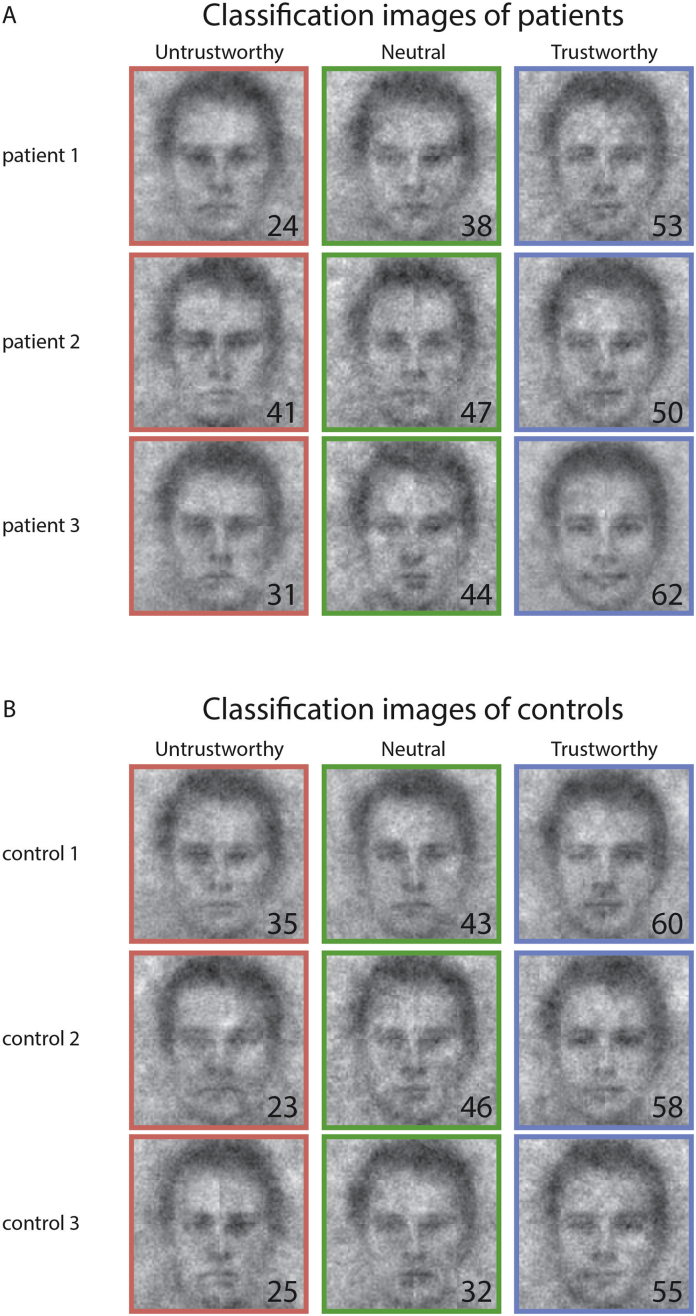
Representative classification images for patients (panel A) and controls (panel B) reflecting trustworthy, neutral and untrustworthy faces. Colours depict the response category of the classification image (untrustworthy: red, neutral: green, trustworthy: blue). The insets in the bottom-right corner depict the average rating on trustworthiness (scale 1–100) by a sample of independent raters.